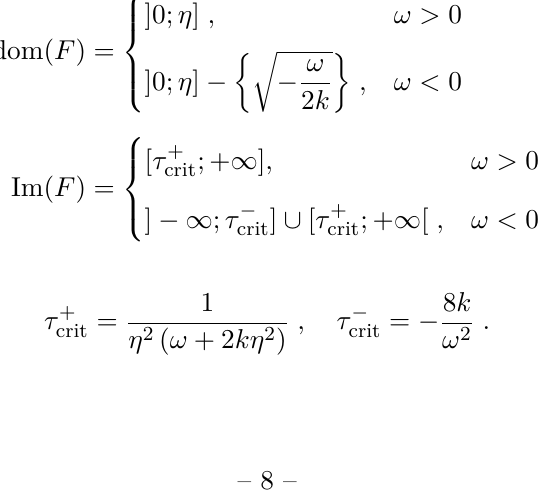
Figure 1 . The modulus of the T ¯ T -deformed bright soliton solution ψ 0 ( x , τ ) at t = 0 and for different values of τ . The parameters are chosen as follows: κ = − 1 / Since ω = − 15 / 4 < 0 , the critical values of τ are τ + to